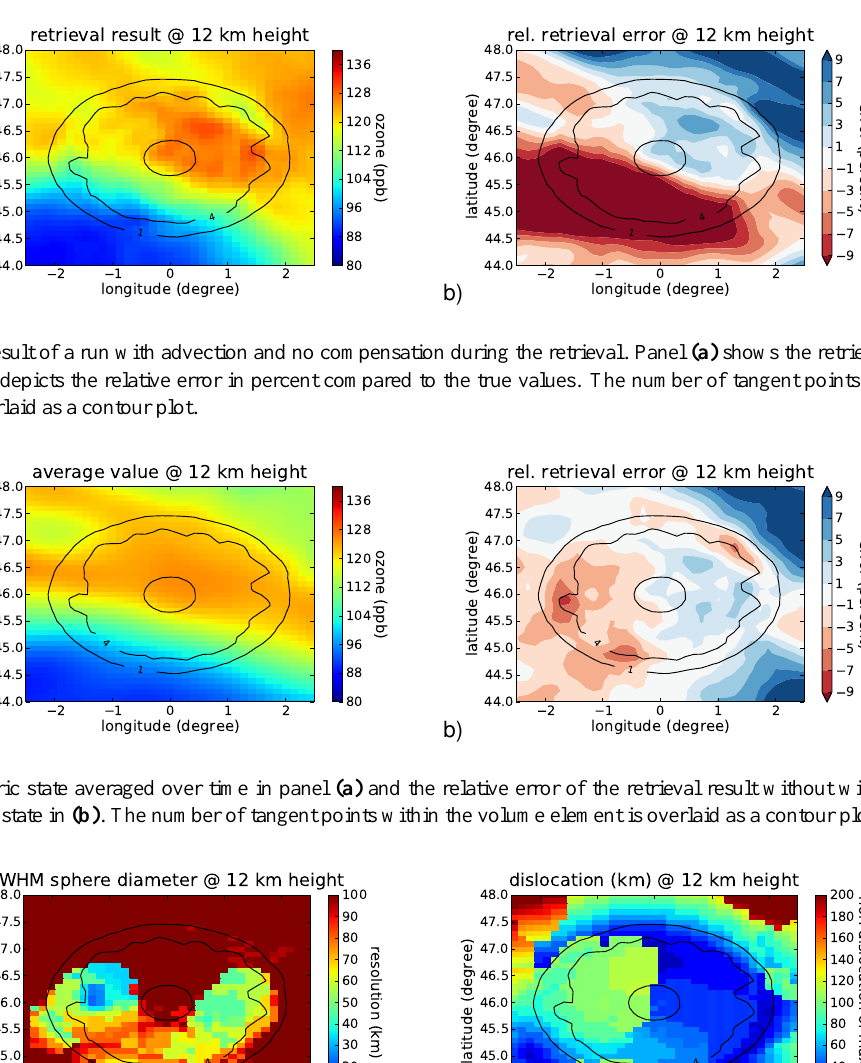
Fig. 14. Horizontal and vertical resolution of a retrieval with perfect wind speed knowledge. Panel (a) shows the FWHM sphere diameter and panel (b) shows the vertical resolution. The number of tangent points within the volume element is overlaid as a contour plot.